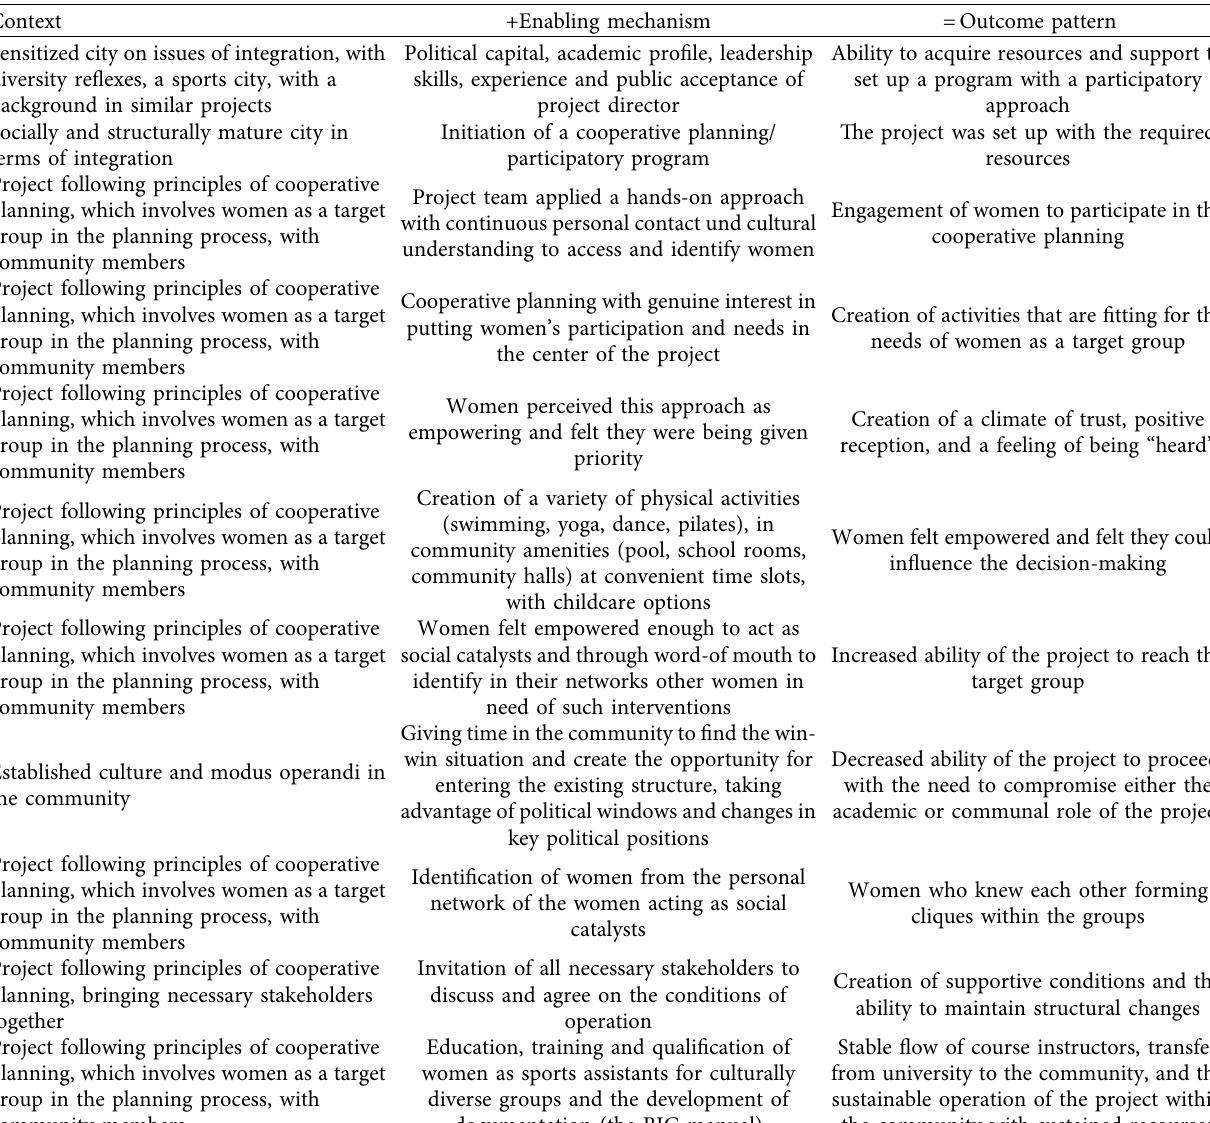
Table 3: Summary of CMO configurations in the BIG project (Bewegung als Investition in Gesundheit: Movement as Investment in Health).